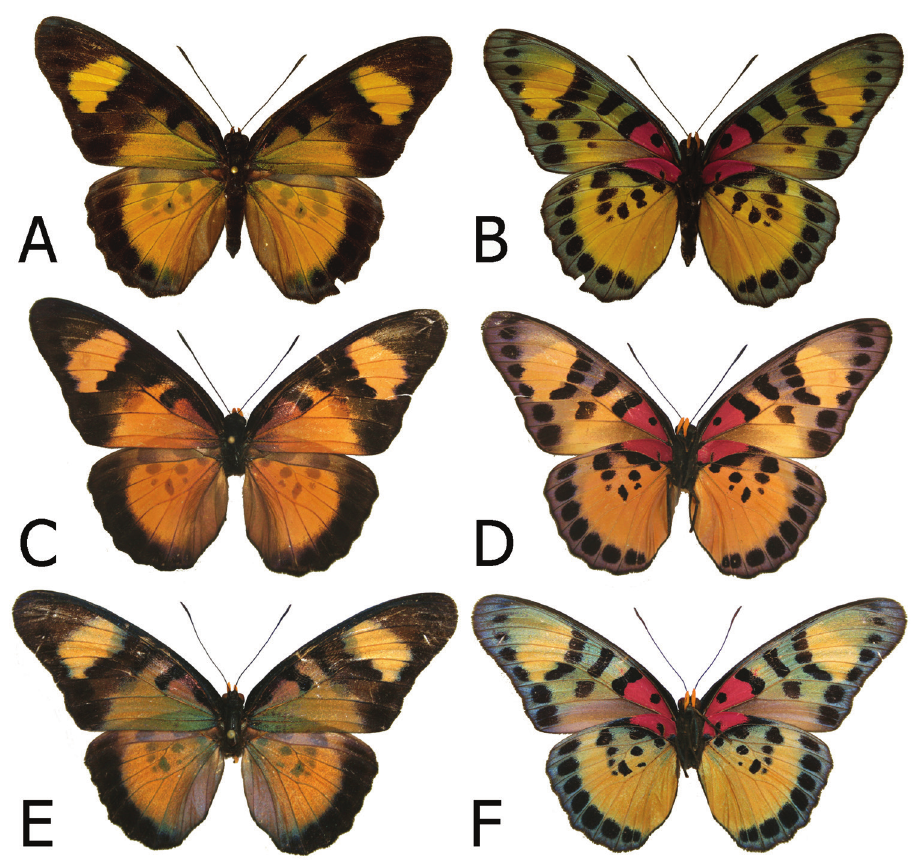
Figure 8. Adults, females : A E. sarcoptera nipponicorum Kigoma, Tanzania (dorsum) B E. sarcoptera nipponicorum Kigoma, Tanzania (venter) C E. sarcoptera nipponicorum Mbandaka, Congo (dorsum) D E. sarcoptera nipponicorum Mbandaka, Congo (venter) e E. sarcoptera nipponicorum Mbandaka, Congo (dorsum) F E. sarcoptera nipponicorum Mbandaka, Congo